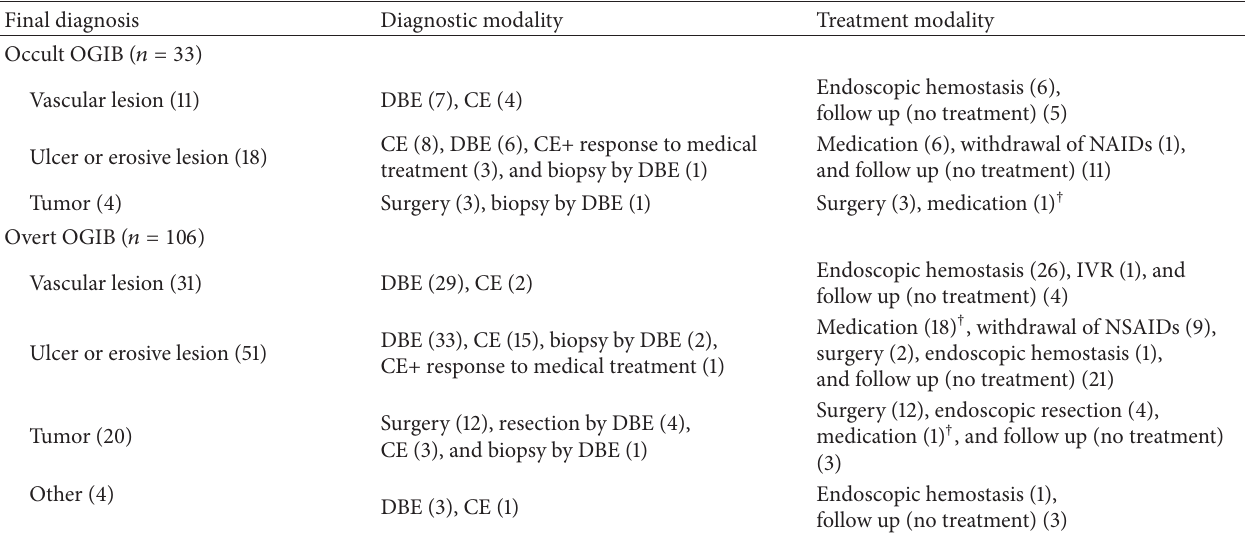
Table 4: Diagnosis (final) and treatment modalities, per bleeding type.